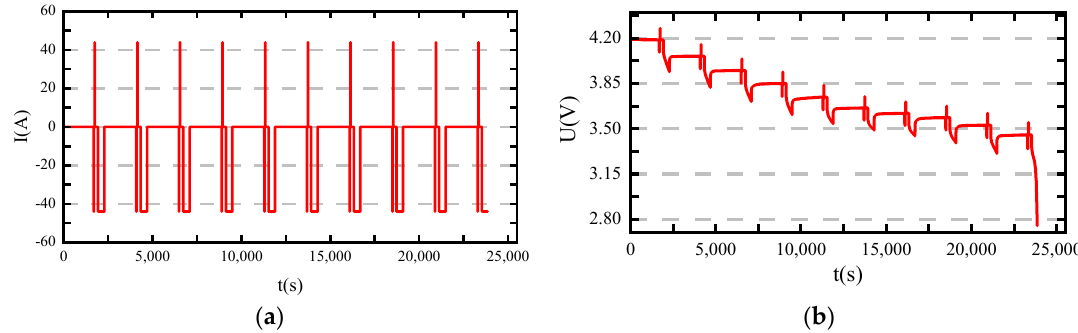
Figure 2. The voltage and current curve of the whole HPPC process. ( a ) The current curve of the HPPC process. ( b ) The voltage curve of the HPPC process.